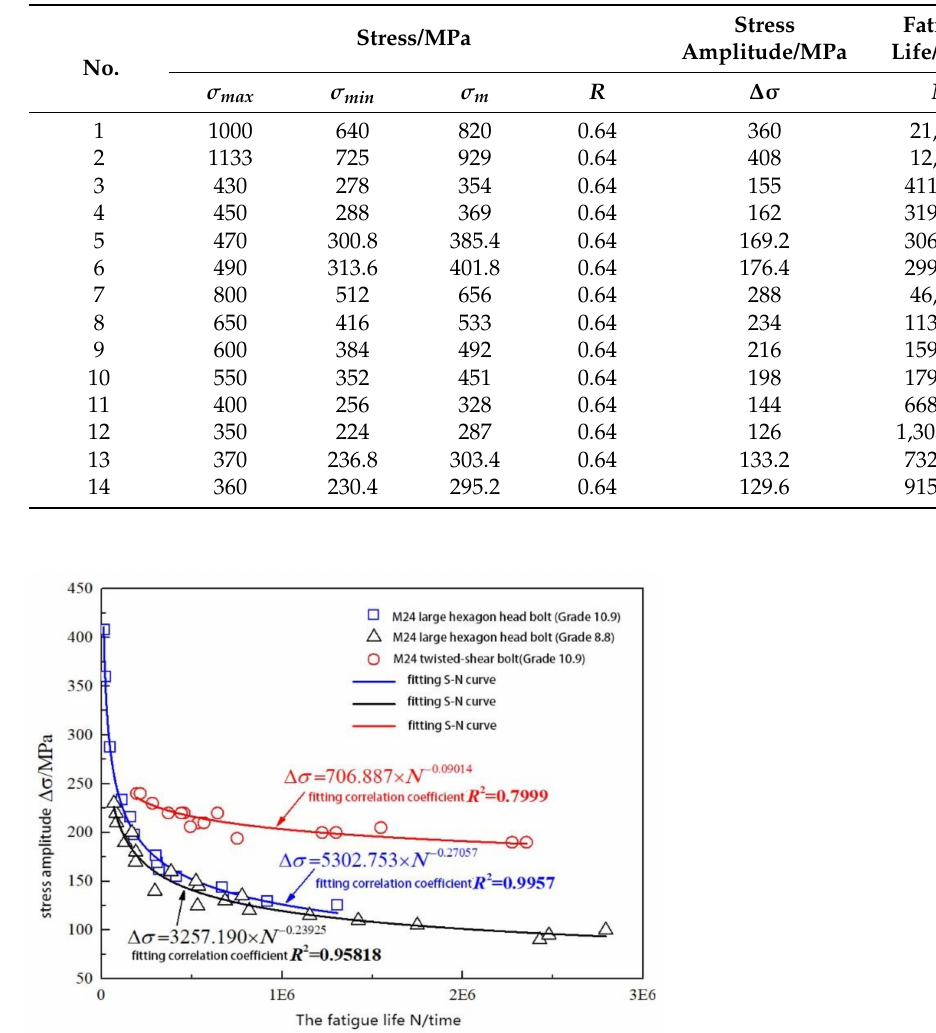
Table 14. Constant amplitude fatigue test data of M24 high-strength bolts with large hexagon head.